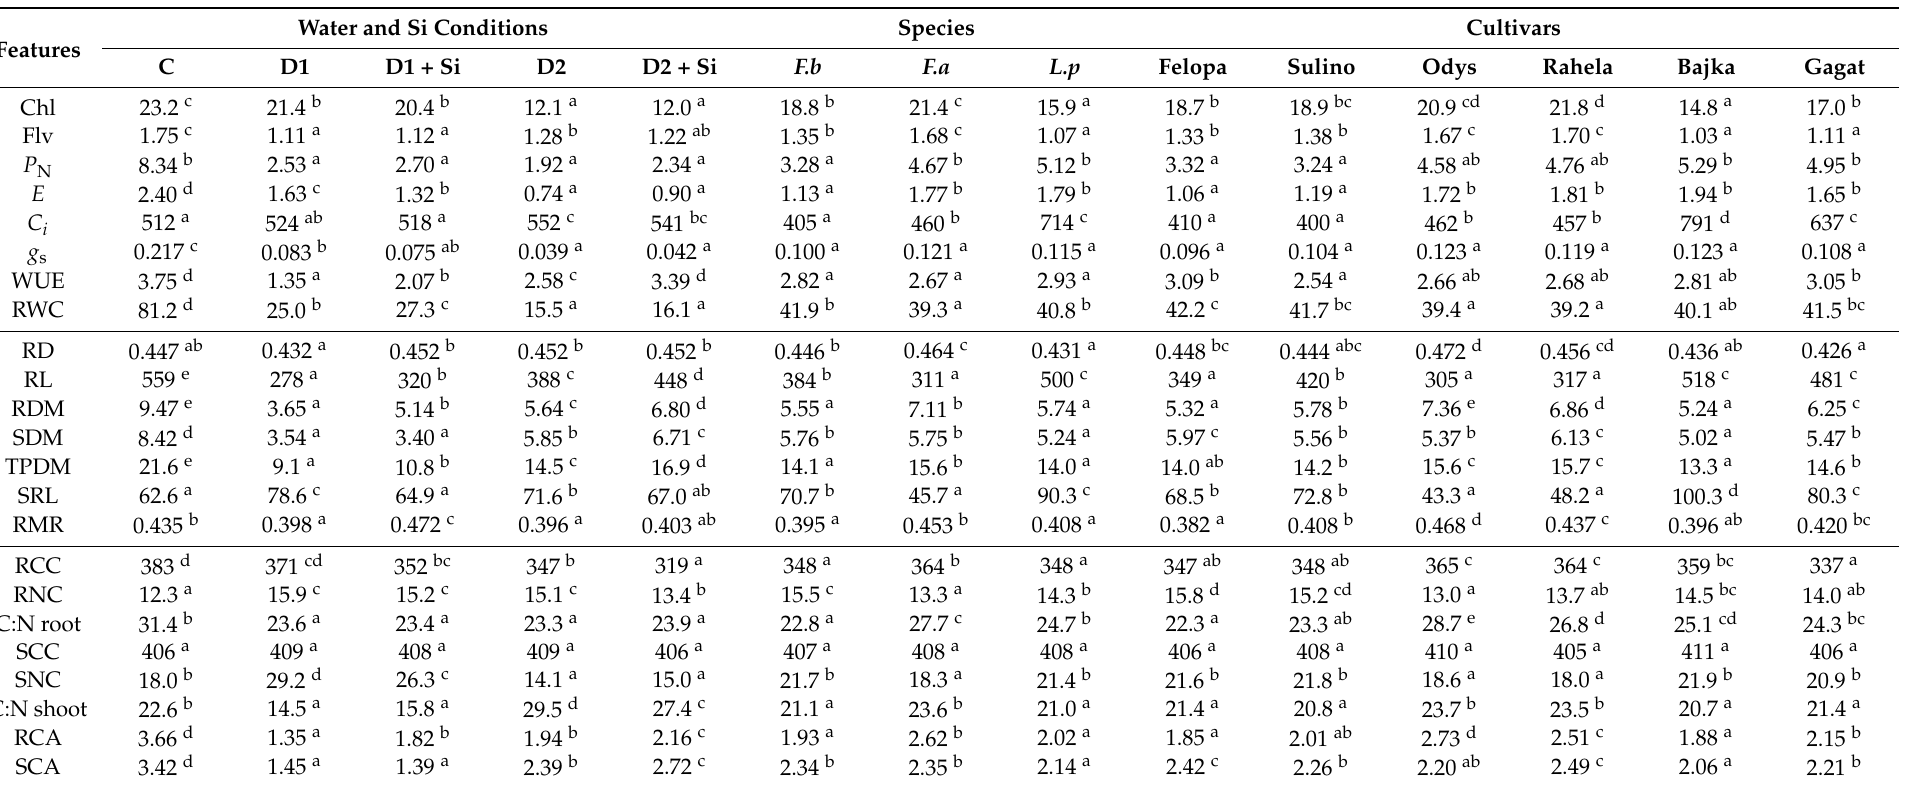
Table 1. Mean values of the studied features according to water (C—control; D1 and D2—water deficits) and silicon (Si) conditions, grass species ( F. braunii — F.b ; F. arundinacea — F.a ; L. perenne—L.p ), and cultivars (Felopa, Sulino, Odys, Rahela, Bajka, Gagat) regardless of the